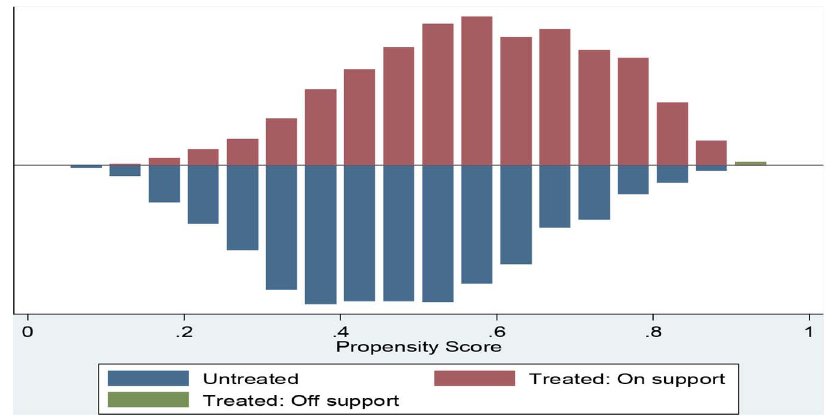
Figure 2. Predicted probability of 1–2 antenatal care visits: Matched sample.